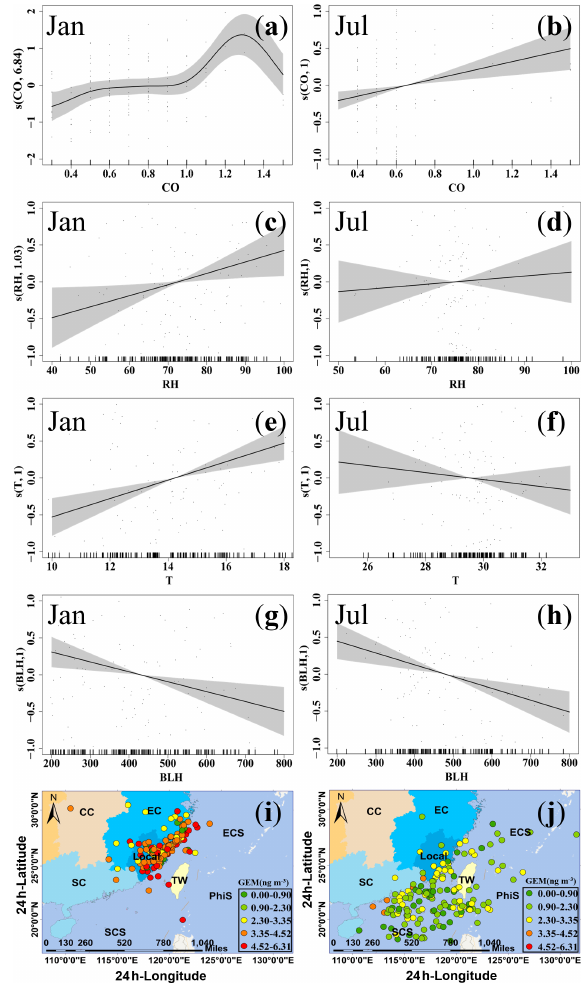
Figure 8. Spline of GEM to the chosen variables, (a, b) CO (mgm − 3 ) in January and July, (c, d) RH (%) in January and July, (e, f) temperature ( ◦ C) in January and July, (g, h) BLH (m) in Jan- uary and July, and (i, j) 24h longitude and 24h latitude in January and July. The grey background around the line is 95% confidence bounds for the response. The short lines on the x axes show the distribution of data points. The numbers in brackets on the y axis labels are the estimated degrees of freedom. The colored dots in (i, j) represent the interactive influence of 24h backward trajectories’ latitude and longitude